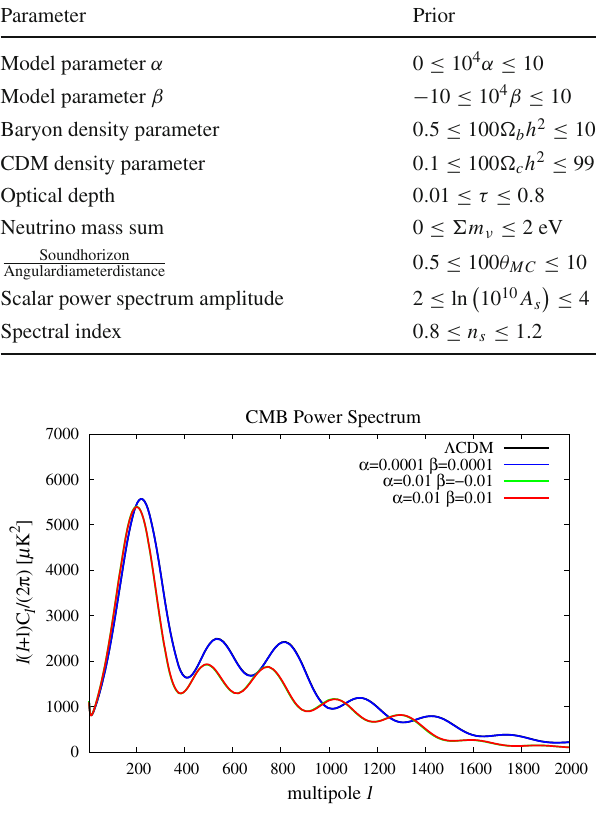
Fig. 1 CMB power spectra for the (cid:2) CDM and RVM with different sets of α and β , where α = 0 . 0001 and β = 0 . 0001 in the RVM are illustrated by the blue line, which almost coincides with the black one from (cid:2) CDM, while the green and red lines with α = 0 . 01 are also almost in the same line